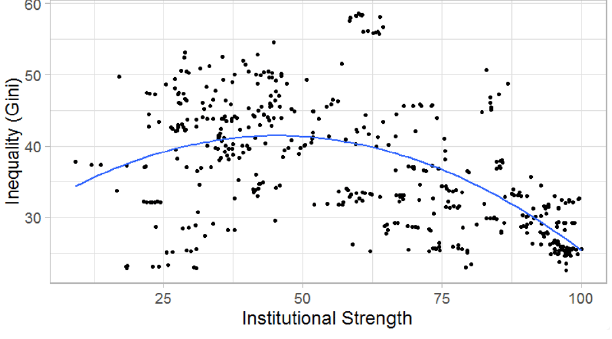
Fig. 3 . The relationship between inequality-institutional interaction in the data across countries resembles an inverted